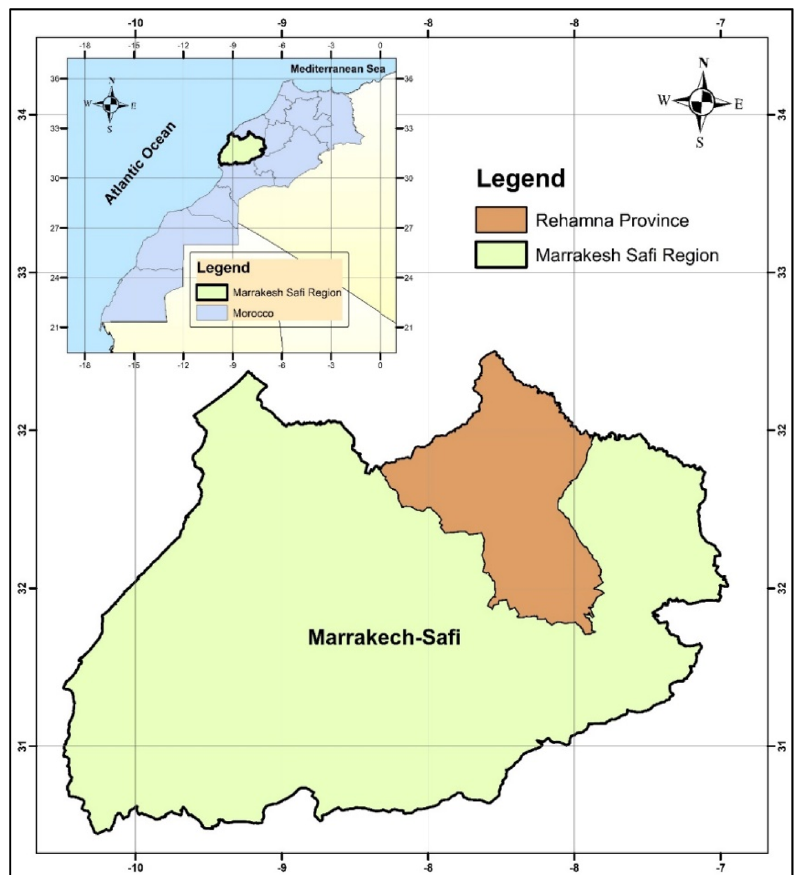
Figure 1. Geographical location of Rhamna